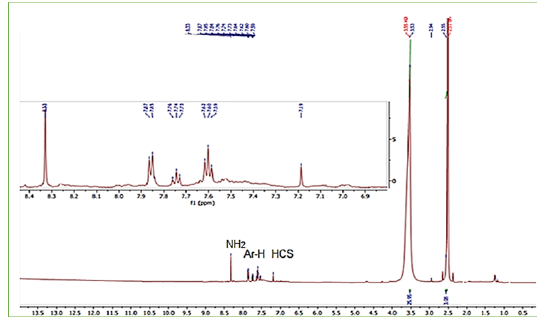
Fig. 4. 1 H NMR of spectrum of palladium complex of 2-Amino 4-